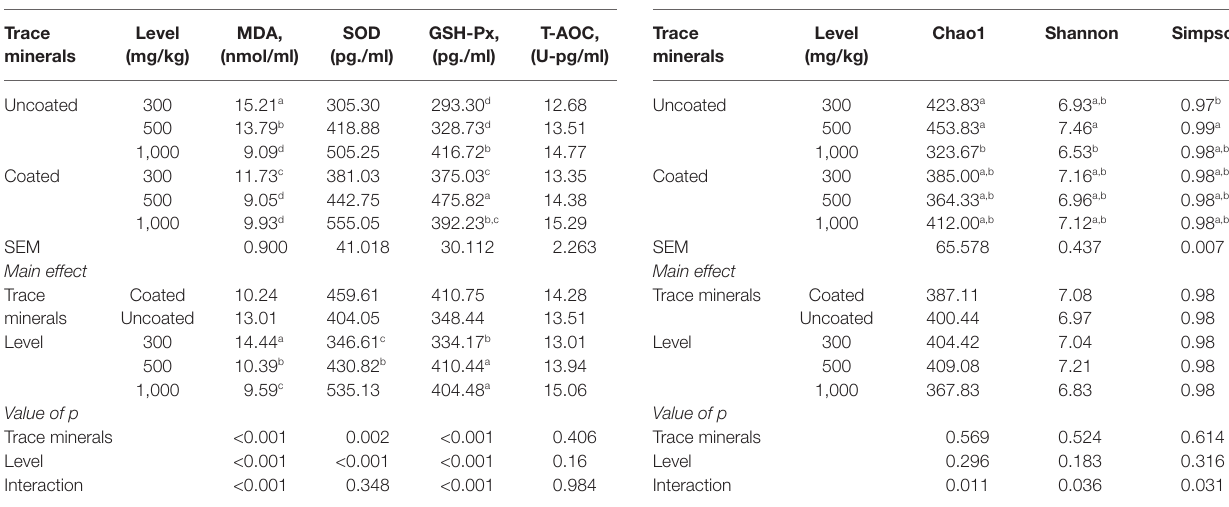
TABLE 8 | Effects of trace mineral type (coated or uncoated) and supplementation level (300, 500, or 1,000 mg/kg) of trace minerals on serum antioxidant status in ducks.